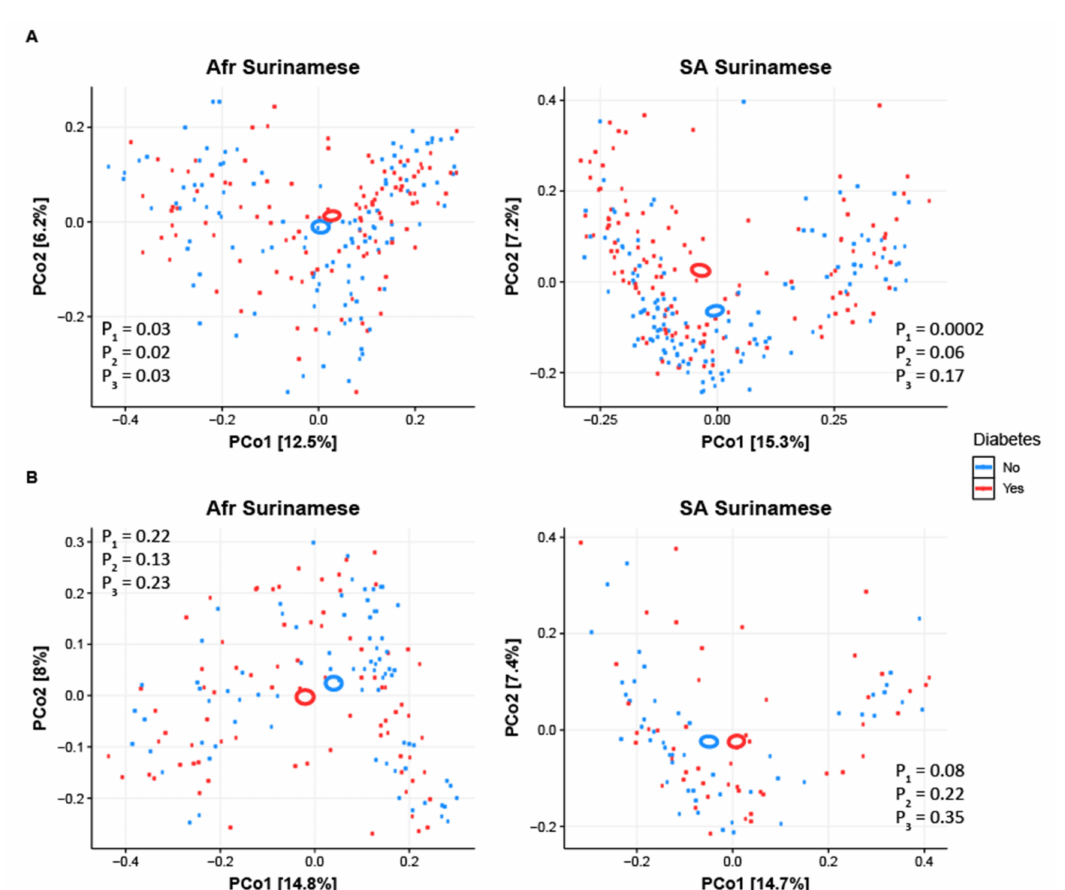
Figure 2. Visualization of the PCoA analysis on the Bray–Curtis dissimilarity index for both African and South-Asian Surinamese in the ( A ) Met-T2D dataset (Met-T2D cases and matched controls) and ( B ) TN-T2D dataset (TN-T2D cases and matched controls) and with p values for the (1) PERMANOVA without adjustment, (2) PERMANOVA with adjustment for age, sex and BMI and (3) PERMANOVA with adjustment for age, sex, BMI and medication